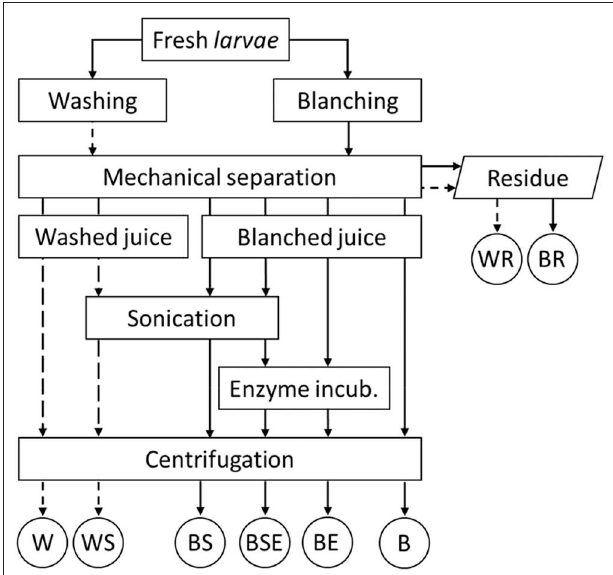
FIGURE 1 | Experimental process design (B, blanched; W, washed; S, sonicated; E, enzyme